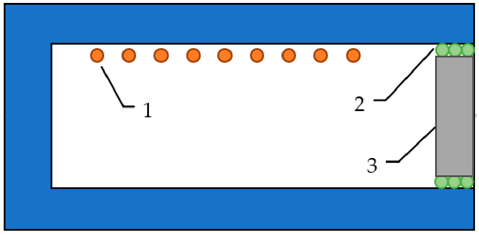
Figure 2. Scheme of the measuring system showing thermal radiation: (1) heating element; (2) high-temperature insulation material; (3) sample.